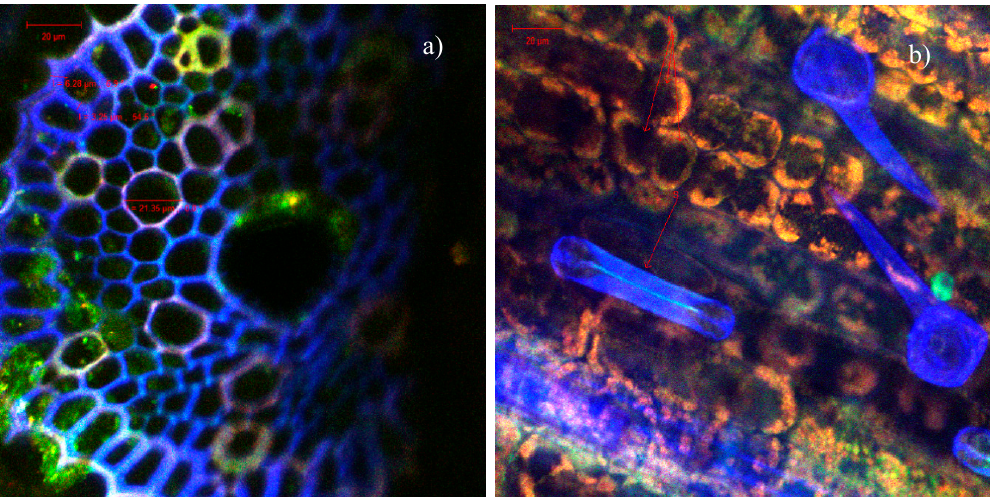
Figure 8. CLSM images of the wheat sprout sections of the indolizine 4a treated samples at two different concentrations: ( a ) 10 − 3 M, ( b ) 10 − 4 M. Catalysts 2020 , 10 , x FOR PEER REVIEW